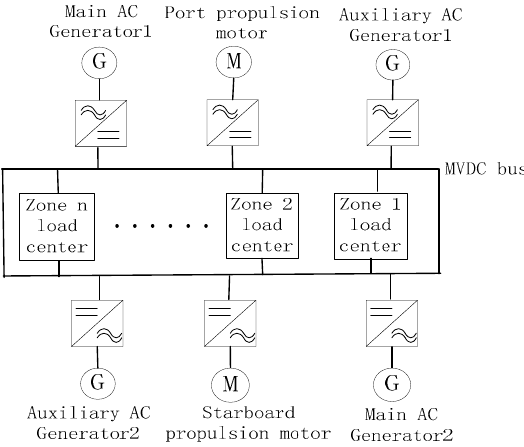
Figure 1. Zonal MVDC shipboard distribution systems.